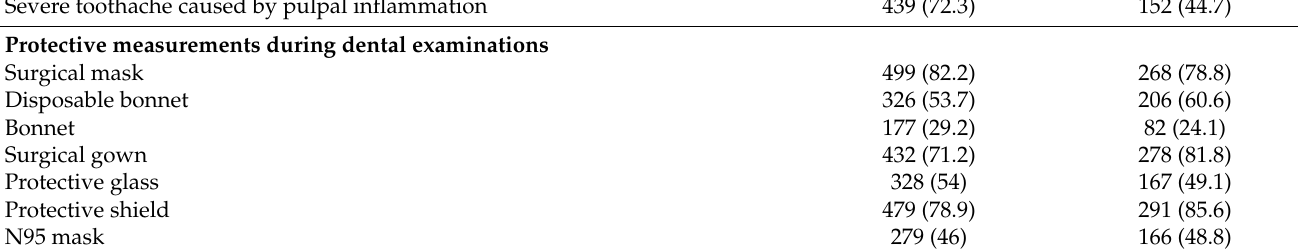
Table 6. The responses of the participants according to the treatment list declared by the TDA.